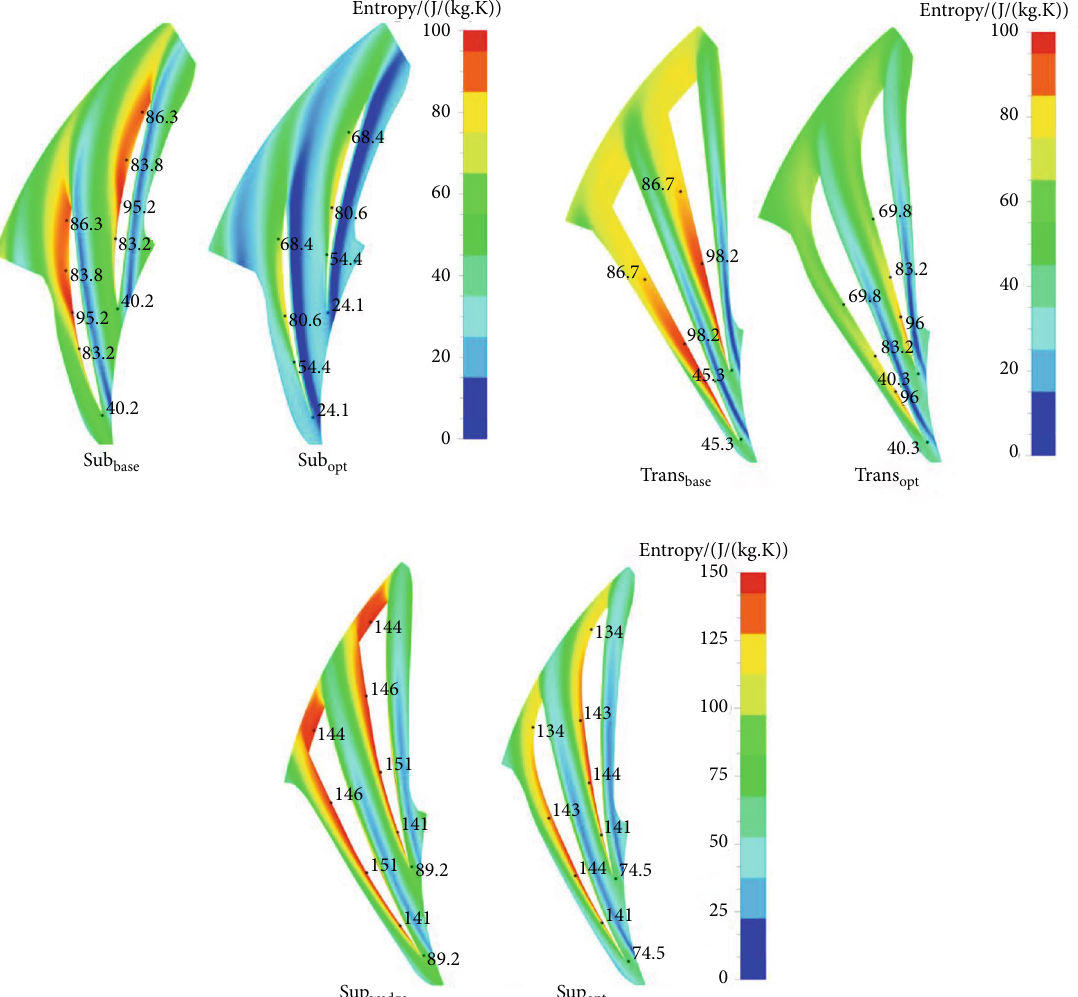
Figure 22: Entropy contours at the